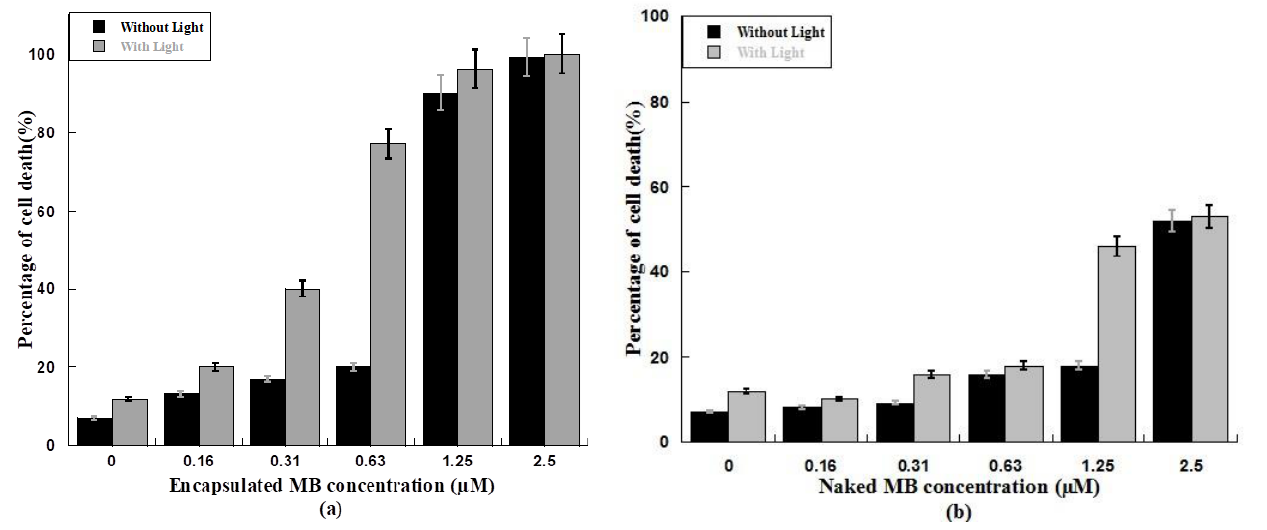
Figure 5. Comparison of cell death percentage with and without irradiation for ( a ) MB encapsulated within SiNPs and ( b ) naked MB.